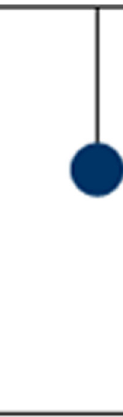
FIG. 17. Figure for Newton ’ s Laws post-test Problem 7.